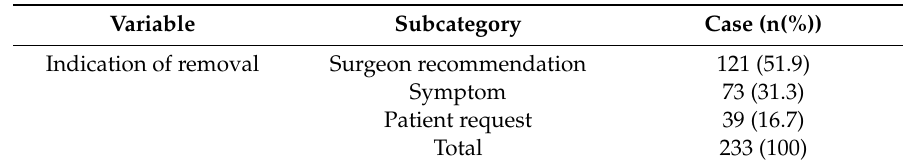
Table 4. Distribution of the indication to remove the titanium plates. Totals of the percentages may not be exactly 100% because of rounding.